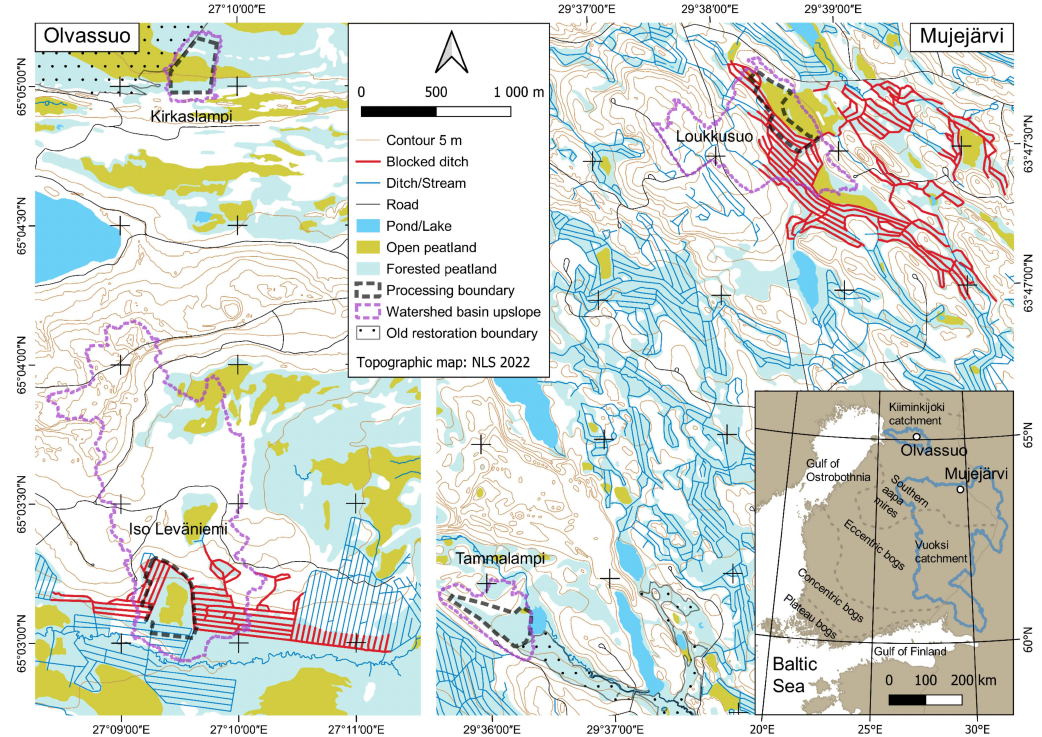
Figure 1. Locations of the study sites. The regions of Olvassuo and Mujejärvi are at the upper end of the catchments in the southern aapa mire zone (classification according to [49]). Loukkusuo and Iso Leväniemi are the restoration sites and Tammalampi and Kirkaslampi are their pristine control pairs, respectively. The processing boundaries do not cover the entirety of the restoration sites but focus on the edges of the downslope open peatland